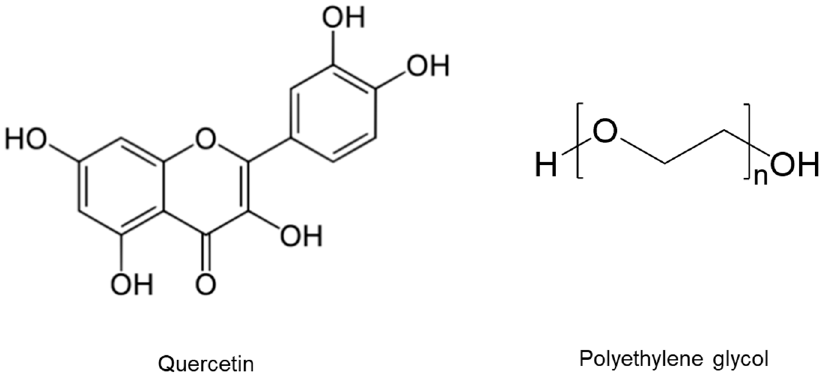
Figure 1. Chemical structures of quercetin and polyethylene glycol.